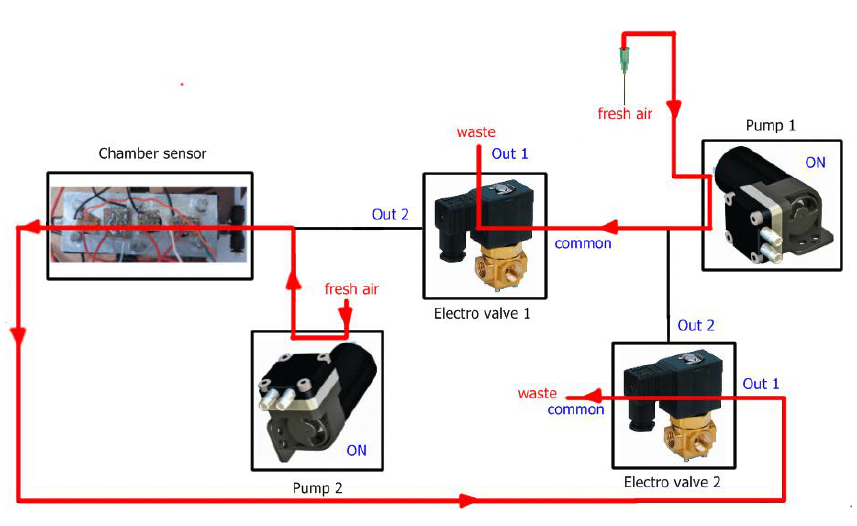
Figure 4. Gases flow at the cleaning1 stage.